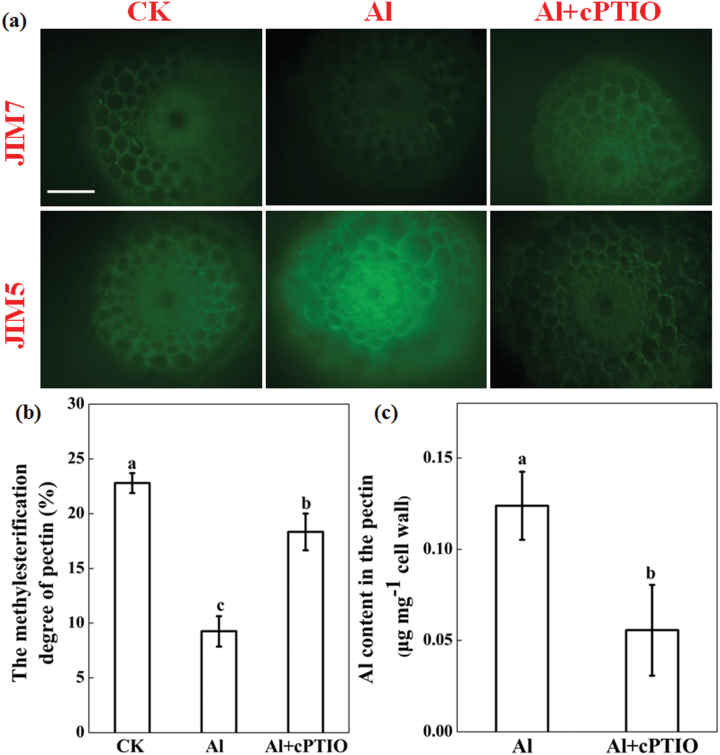
Effect of Al and cPTIO on the degree of pectin methylation and cell wall pectin Al content. Three-day-old wheat seedlings were treated with 0.5mM CaCl2 solution containing 0 or 30 μM Al with or without 30 μM cPTIO for 24h. (a) Immunolocalization of high methylesterified pectin (JIM7) and low methylesterified pectin (JIM5) in cross-sections of 10-mm root apices. Scale bars, 50 μm. (b) Degree of methylation of cell wall pectin extracted for root apices. (c) Al content of cell wall pectin. Means ± SD (n = 3). Means with different letters are significantly different at P < 0.05.